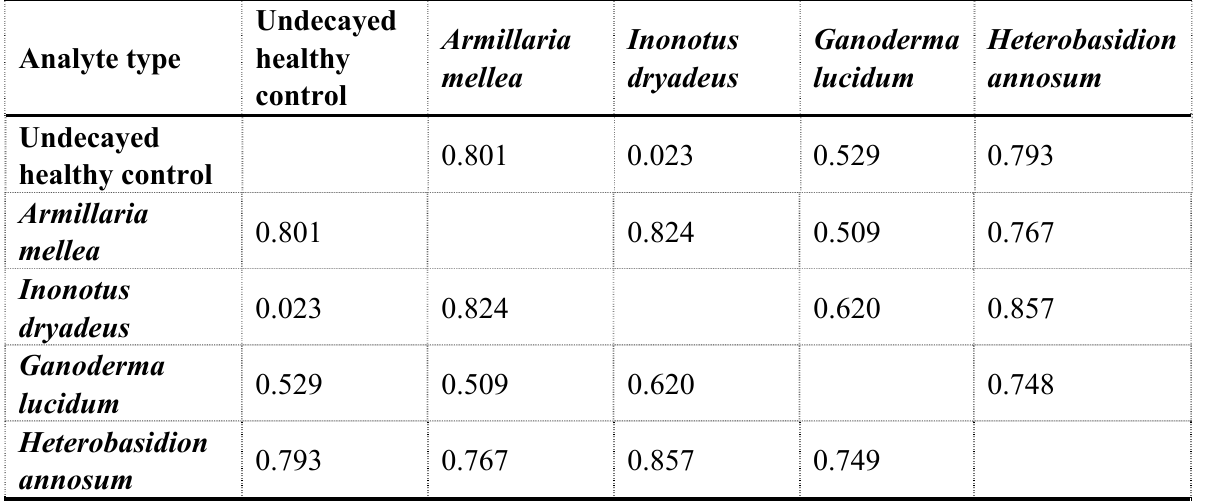
Table 8. The discrimination power of the PEN3 e-nose for distinguishing decay of Aesculus hippocastanum wood blocks, caused by four different species of wood decay fungi, based on PCA by pair-wise comparisons of headspace volatiles. Principal component 1 and principal component 2 explained 65.2% and 28.9%, respectively of the sample variance ( σ 2 ) in the data. The data values indicate the decimal fraction overlap of principal component aroma elements that the sample analytes share in common. By definition, a specific analyte shares all principal components when compared against itself and the theoretical decimal fraction overlap is 1.000 for self-comparisons.